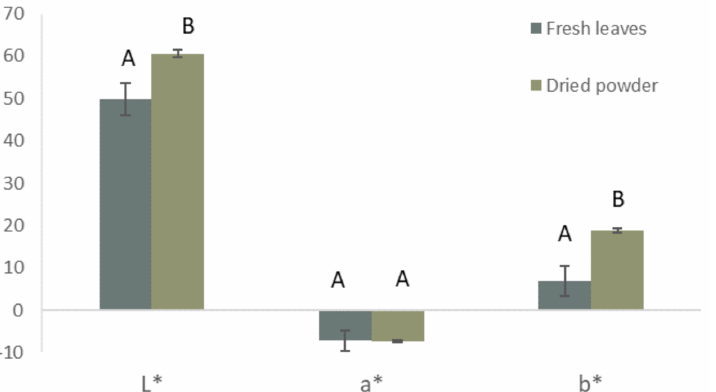
Figure 4. Color parameters of fresh leaves and dried powder of H. portulacoides . Bars with the same letter are not statistically different for each of the color coordinates. The color used for each series in the graph is the estimated real color of sea purslane in the fresh and dried